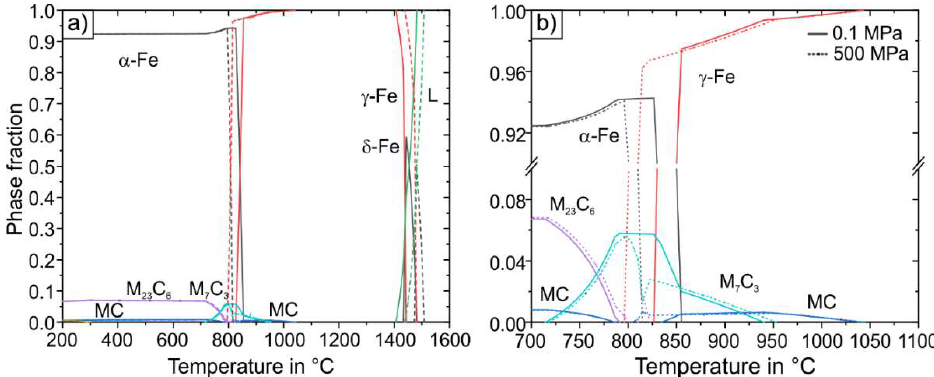
Figure 3. Phase fraction diagram of X37CrMoV5-1 calculated using the CALPHAD method showing ( a ) the full stability range of all phases and ( b ) considered carbides in detail.